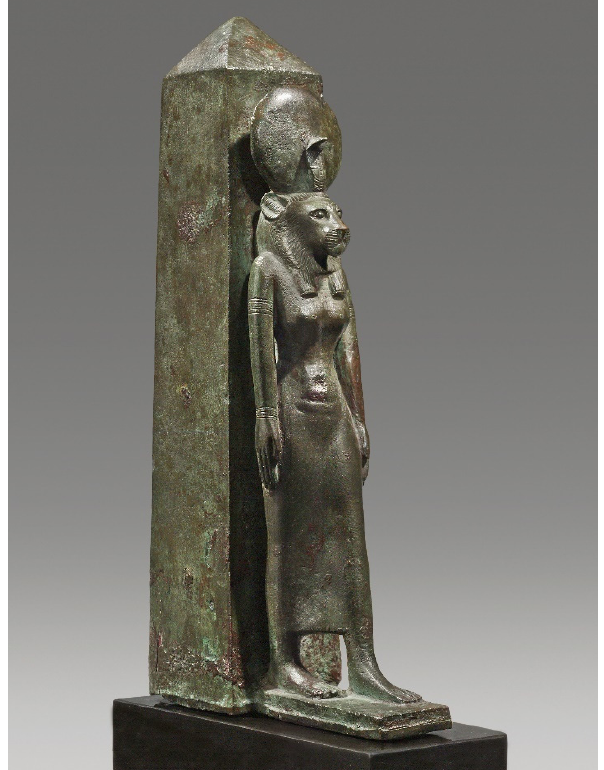
Figure 2. A bronze reliquary for an ichneumon dedicated to the Egyptian goddess Wadjet, three- quarter view from the right (Private collection, courtesy of the owner).